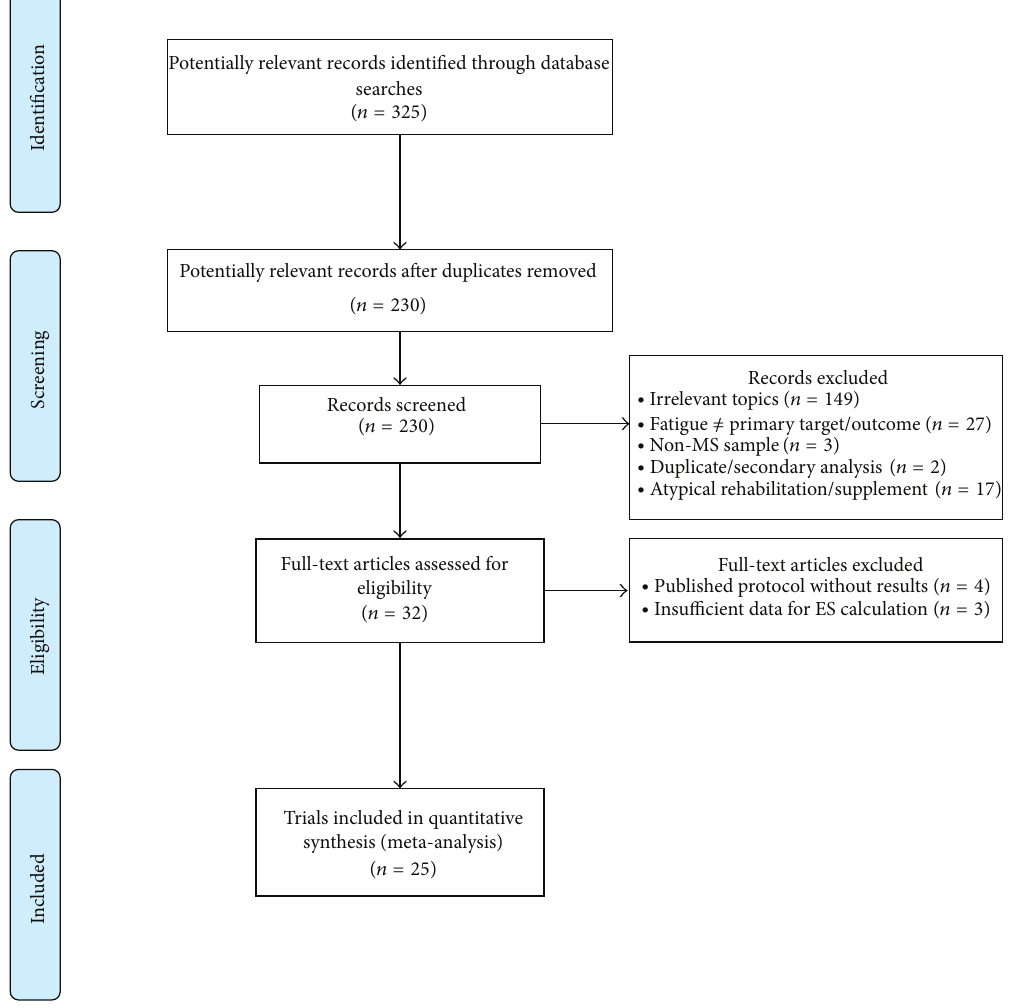
Figure 1: Review flow